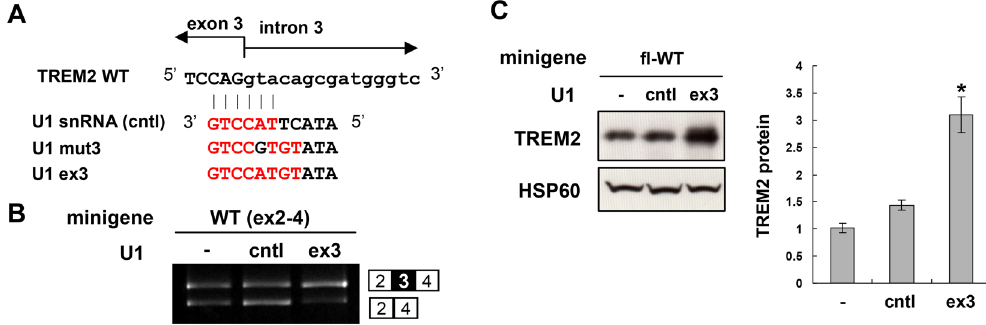
Figure 6. Induction of exon 3 inclusion of fl-WT minigene increased TREM2 protein expression. ( A ) Structure of the 5 ′ end of unmodified U1 snRNA (cntl) and modified U1 construct based on U1mut3 but matches wild- type (WT) exon 3. ( B ) Splicing assay of WT(ex2-4) minigene transfected with unmodified U1 snRNA or the U1-ex3 construct in HEK cells. ( C ) U1-ex3 increased TREM2 protein expression from the fl-WT minigene in HEK cells. Western blot analysis of TREM2 expression (left panel). Bar chart shows the quantification of the western blot results (mean ± SE, n = 4). * P = 0.00013 (- vs . ex3) and P = 0.0007 (cntl vs . ex3) in Tukey’s multiple comparison test. Original gel images and western blot data are shown in Supplementary Fig. S8.